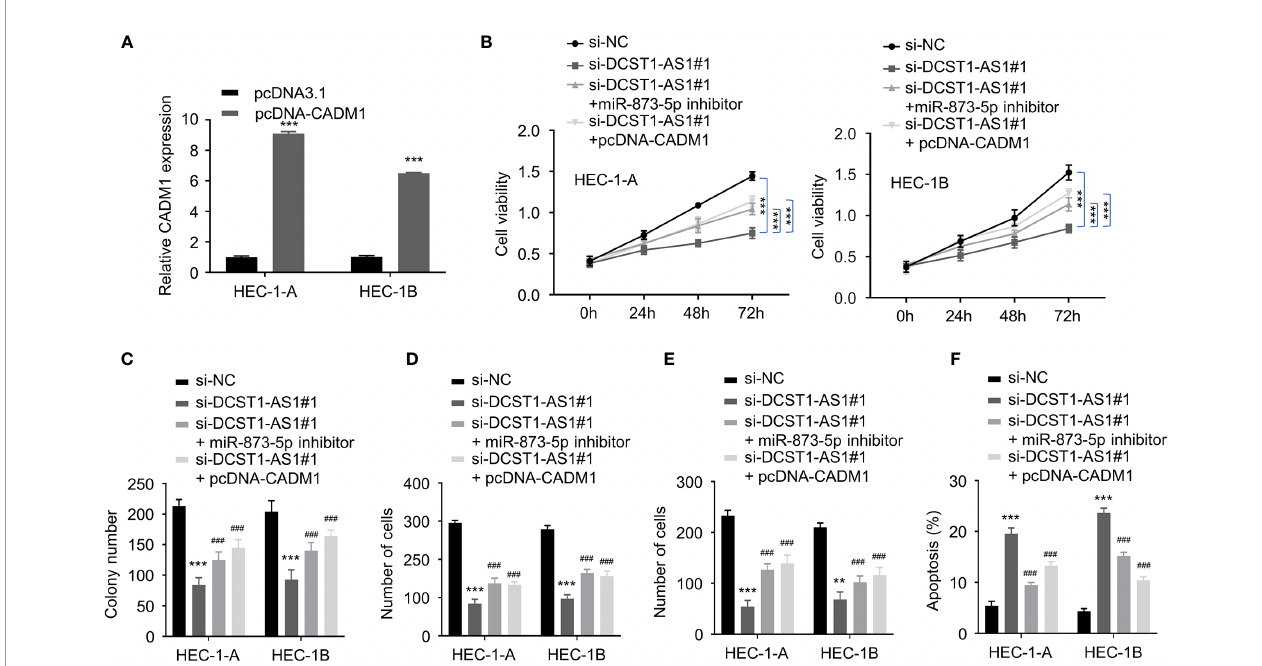
FIGURE 7 | LncRNA DCST1-AS1 promotes the malignant features of EC cells through miR-873-5p/CADM1 signaling. (A) qRT-PCR analysis of CADM1 expression in EC cells transfected with CADM1 overexpression plasmid or control plasmid. (B) CCK-8 assay showed that either miR-873-5p inhibition or CADM1 overexpression rescued EC cell proliferative reduced by DCST1-AS1 knockdown. (C) Colony formation assay of EC cells transfected as indicated. (D, E) Transwell migration and invasion assay showed that either miR-6873-5p inhibition or CADM1 overexpression rescued EC cell migration (D) and invasion (E) that was suppressed by DCST1-AS1 depletion. (F) HEC-1A and HEC-1B cells were transfected as indicated, and cell apoptosis was determined by FACS analysis. ** P < 0.01, *** P < 0.001. ### P < 0.001, compared with siDCST1-AS1#1